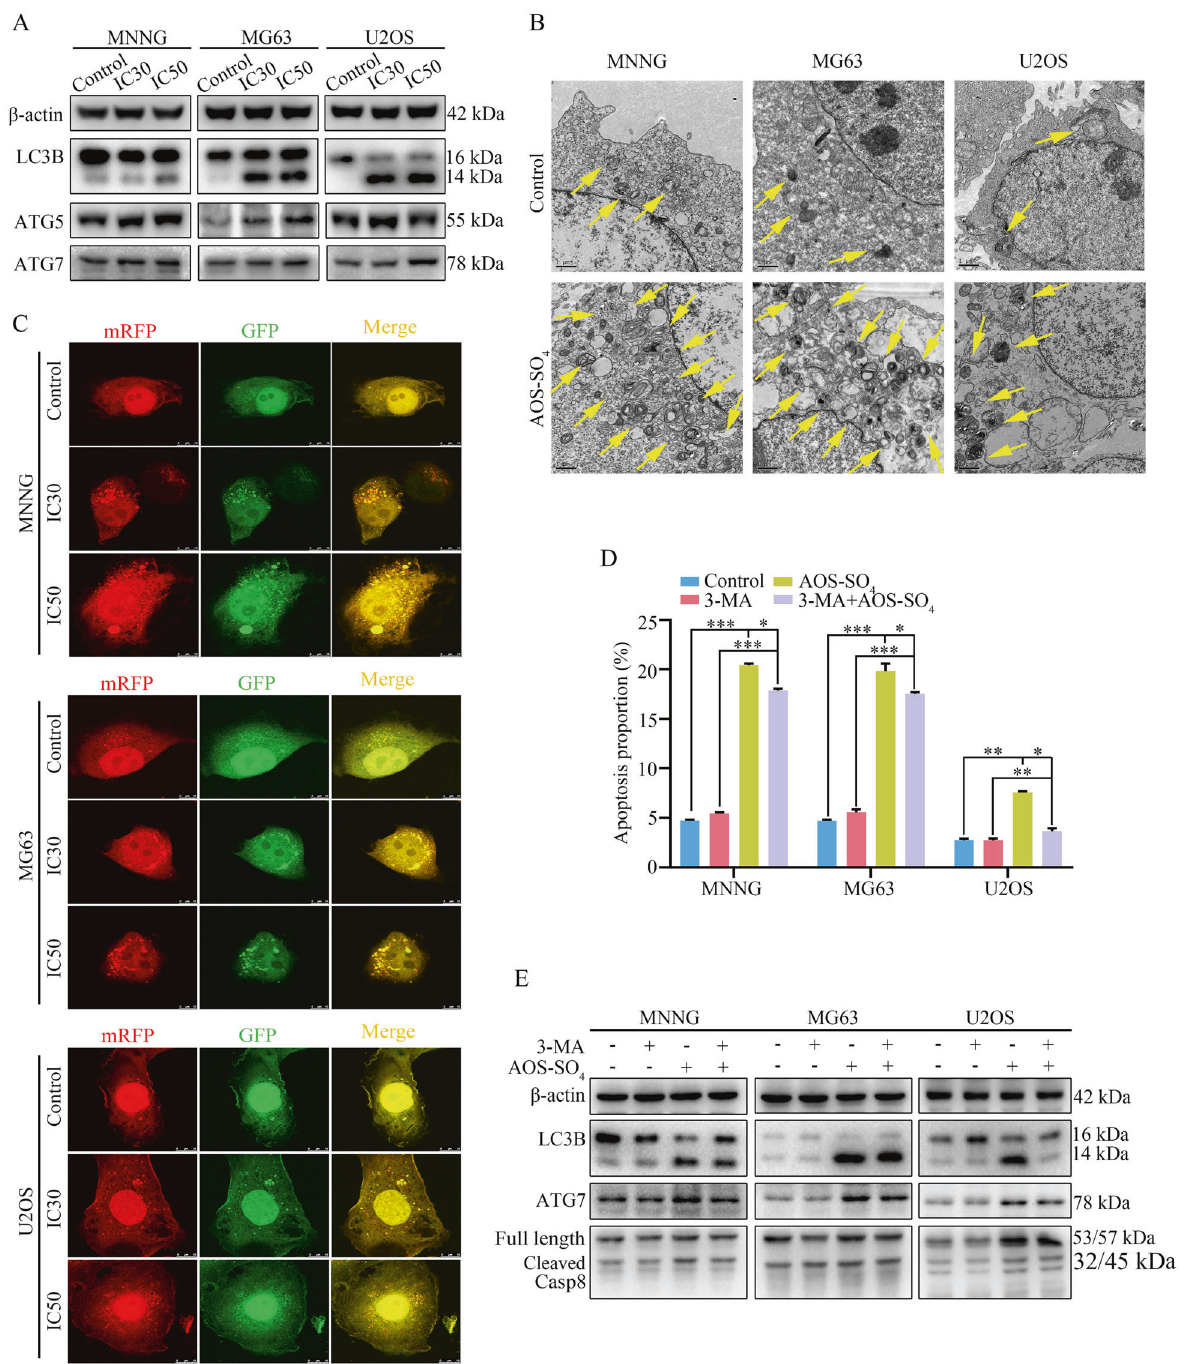
Fig. 4 AOS-SO 4 promotes autophagy in osteosarcoma cells. A After treatment with AOS-SO 4 for 48 h, the protein levels of LC3B, ATG5, and ATG7 were assayed by western blot in osteosarcoma cells. B In parallel, autophagosome-like structures (indicated by the yellow arrows) were assayed by TEM. C LC3 puncta were analyzed by the mRFP-GFP-LC3 construct. D Osteosarcoma cells were treated with AOS-SO 4 for 48 h with or without 3-MA (0.5 mM, 2 h), and fl ow cytometry was used to analyze apoptosis. E Representative blots of LC3B, ATG7, and Casp8 in MNNG, MG63, and U2OS cells after treated with AOS-SO4 for 48 h with or without 3-MA. Data are shown as the means ± SD from at least three independent experiments. Statistical analysis was performed using Student ’ s t -test. Error bars represent the SEM. * P < 0.05; ** P < 0.01; *** P <